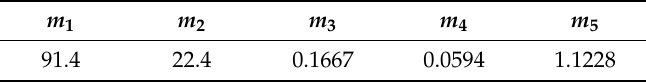
Table 2. The calculation results of the material